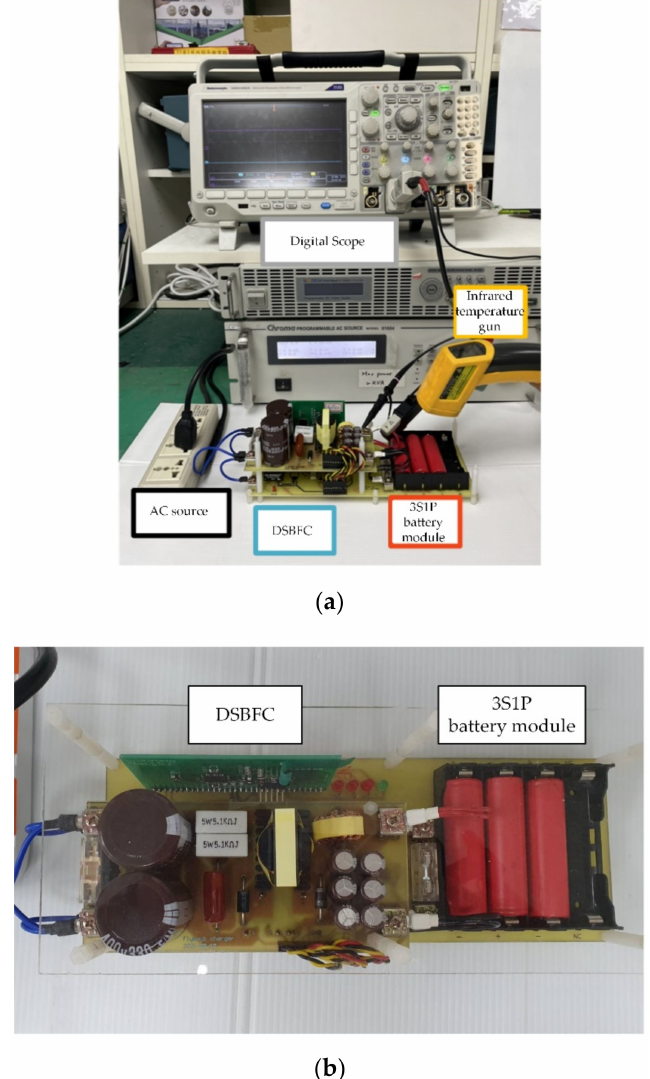
Figure 9. Laboratory setup diagram of the battery-charging system: ( a ) overall view of the experiment; ( b ) real photograph of the DSBFC and 3S1P battery